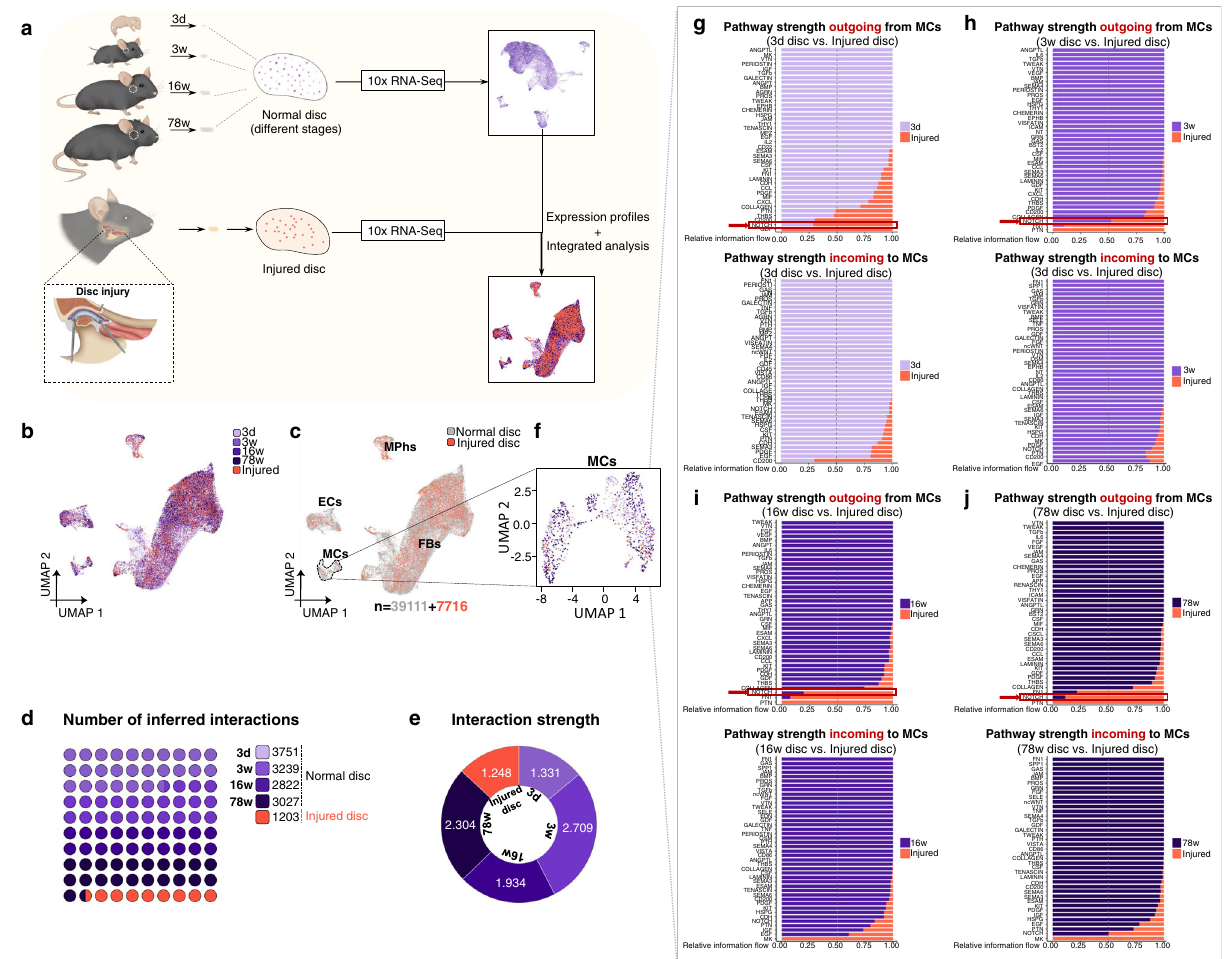
Fig. 7 | NOTCH pathway is the target signaling for MCs expressional and functional changes after disc injury. a Schematic of the TMJ disc injury mouse model and integrated single-cell transcriptomic analyses using both normal and injured disc cells. b Dimension reduction presentation ( via UMAP) of integrated single-celltranscriptome datafor alldisc samples. Each dotrepresents a singlecell and is labeled by different color depths according to stage and injury condition. c Dimension reduction presentation ( via UMAP) of integrated single-cell tran- scriptomedatafornormaldisccells(ingrey)andinjureddisccells(inred).Eachdot representsasinglecell,theretained cellnumberis46827. d Proportionofinferred signalinginteractionnumbersinnormalandinjuredTMJdisccells. e Proportionof signaling interaction strength in normal and injured TMJ disc cells. f UMAP plot of